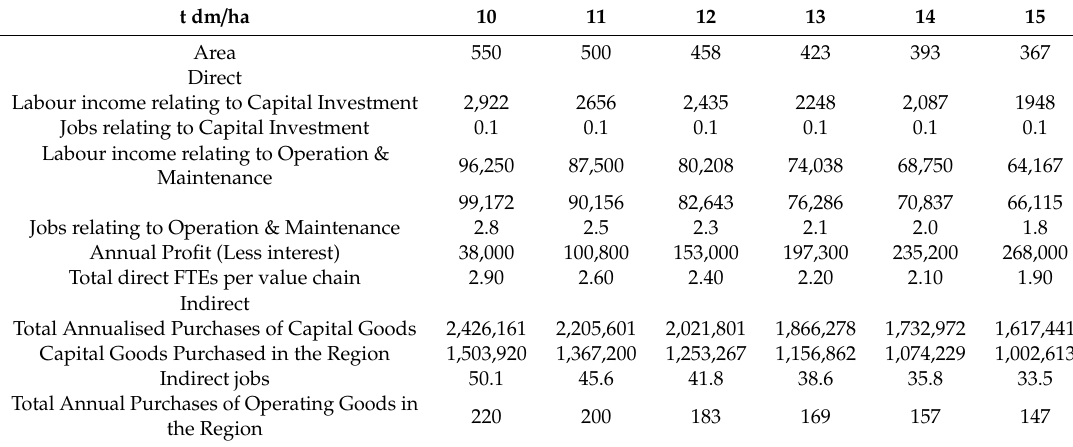
Table A6. Net impacts from the cultivation of Miscanthus for small scale CHP; 1